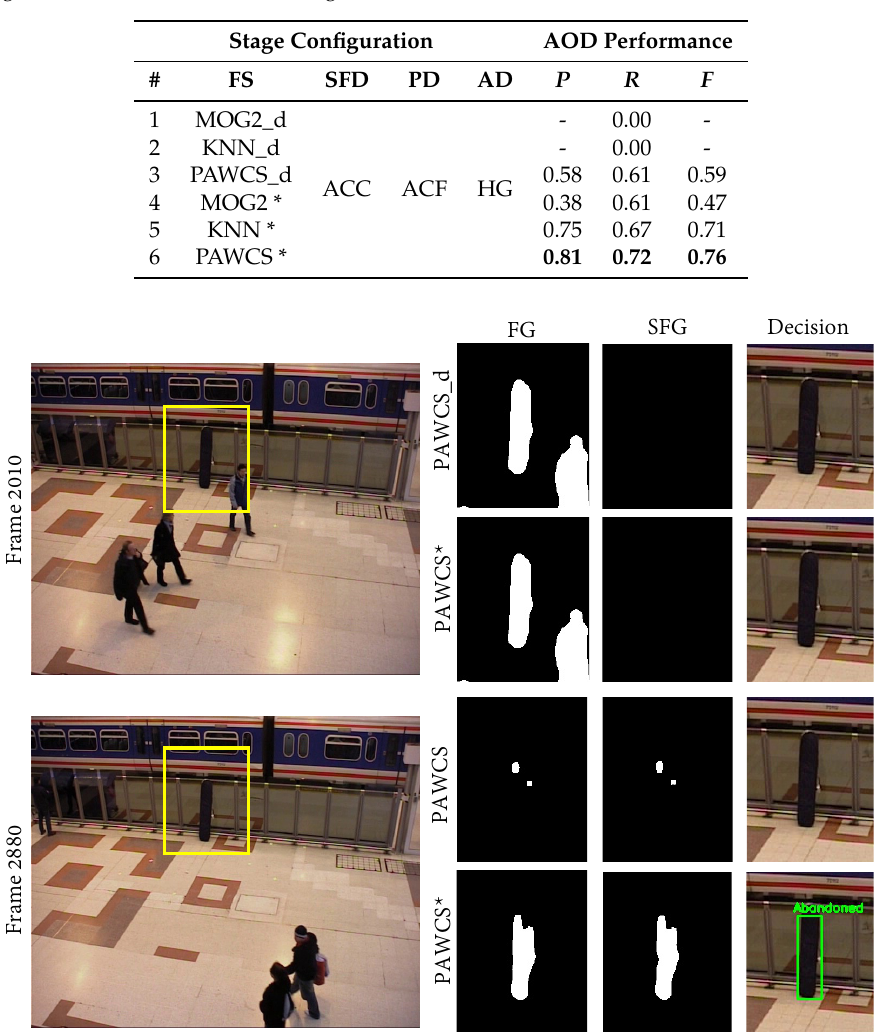
Figure 10. Columns from left to right show the frame image with event ROI marked in yellow, foreground mask, static foreground mask, and final decision. The first and second row show visual results at different stages of Frame 2010, when the object has just been left. Both default and tuned PAWCS detect the object as part of the foreground; however, for a further frame (third and fourth rows), only tuned PAWCS maintains the object detection, while default PAWCS misses the abandoned